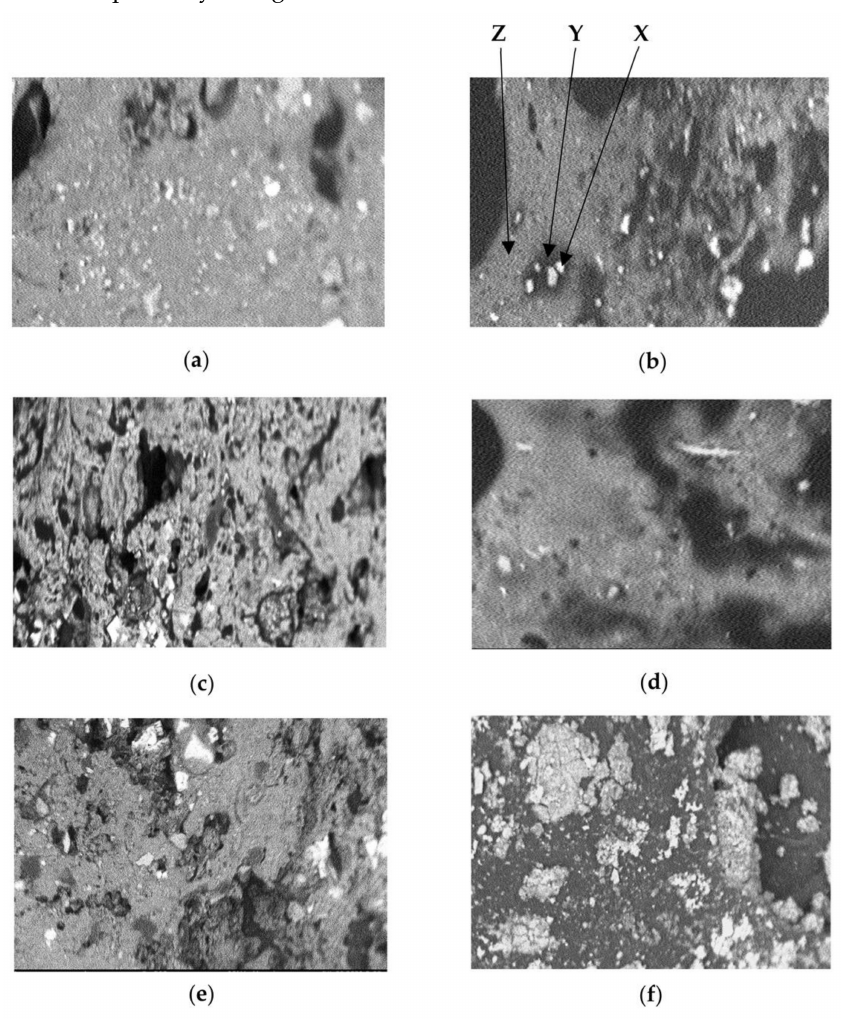
Figure 1. SEM of ( a ) unloaded nanoparticles; ( b ) PRG-based insulin nanoparticles; ( c ) PC201-based insulin nanoparticles; ( d ) PC101-based insulin nanoparticles; ( e ) PC102-based insulin nanoparticles; ( f ) CTS-based insulin nanoparticles (1000 ×